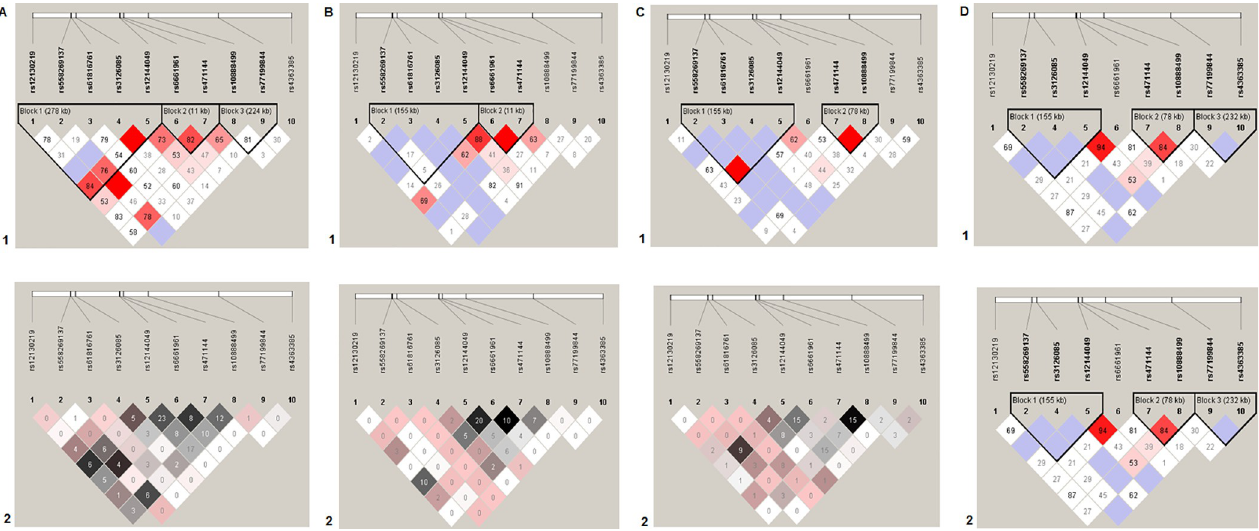
Fig 1. Linkage disequilibrium (LD) between ten studied SNPs of the FLG gene in females (A and B) and males (C and D). A and C—AD patients, B and D— control group. LD values are presented as Lewontin’s standardized coefficient D 0 (Figure sections 1) and the square of the Pearson’s correlation coefficient (r 2 ) (Figure sections 2) between the SNPs.